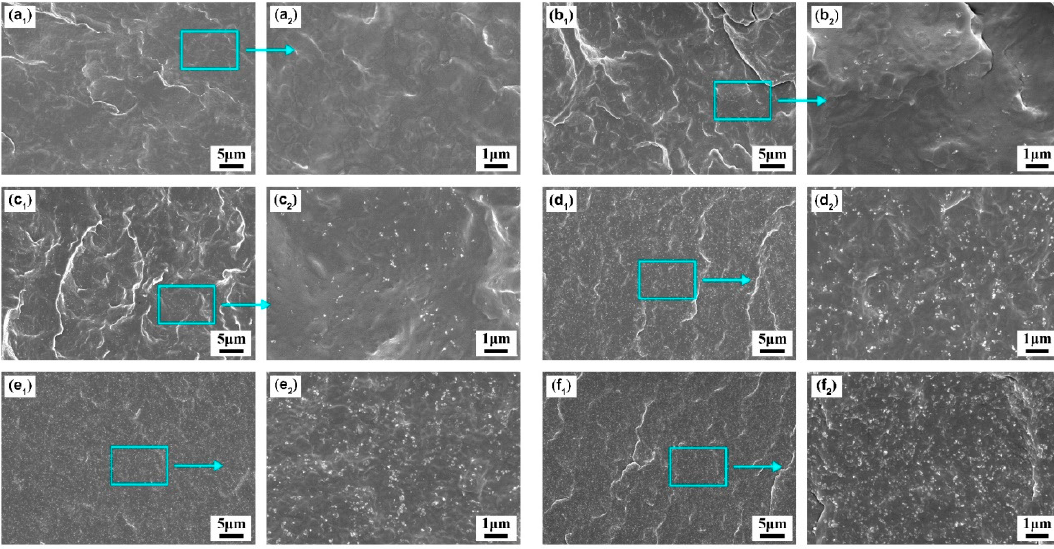
Figure 2. SEM micrographs of PBS / CB nanocomposites: ( a 1 , a 2 ) PBS0; ( b 1 , b 2 ) PBS0.5; ( c 1 , c 2 ) PBS1; ( d 1 , d 2 ) PBS3; ( e 1 , e 2 ) PBS5; ( f 1 , f 2 ) PBS10.